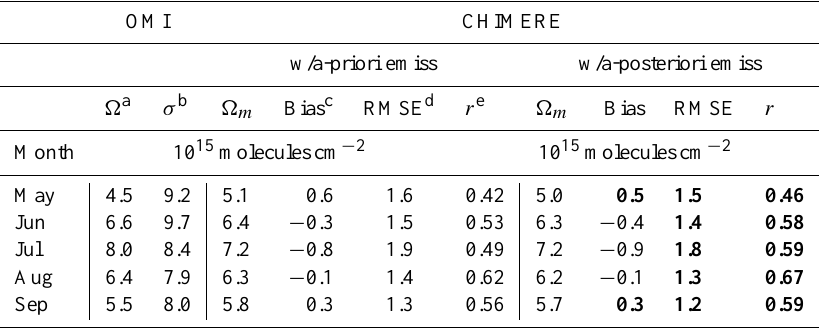
Table 1. Monthly mean comparison of continental European (35 ◦ –58 ◦ N; 15 ◦ W − 25 ◦ E) OMI HCHO column and the CHIMERE model with a-priori or a-posteriori (OMI-derived) VOC emissions during May–September 2005. Boldface font for indices better with a-posteriori emissions. OMI CHIMERE w/a-priori emiss w/a-posteriori